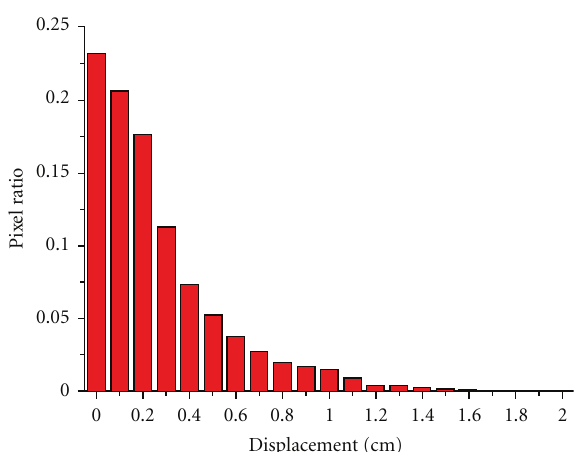
Figure 4: Histogram of the displacement error distribution of the 2D